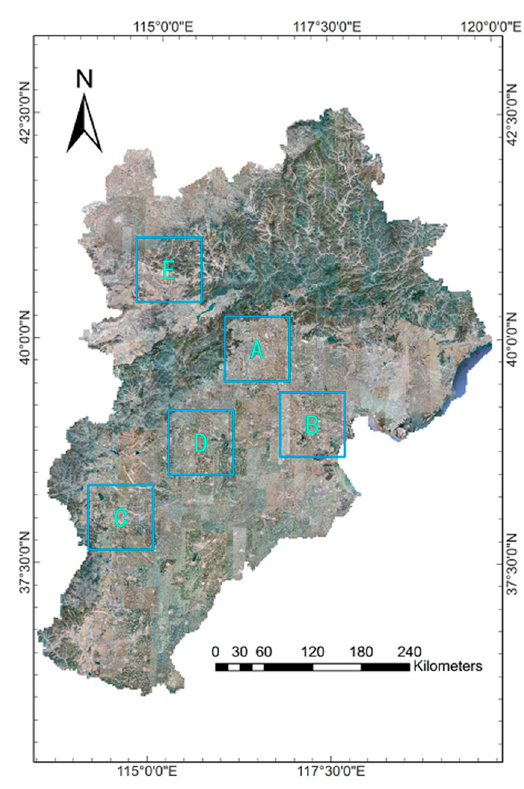
Figure 6. Five regions with different population density in experimental area. ( a ) Beijing, ( b ) Tianjin, ( c ) Shijiazhuang, ( d ) Baoding, and ( e ) Zhangjiakou. Result of this study WorldPop